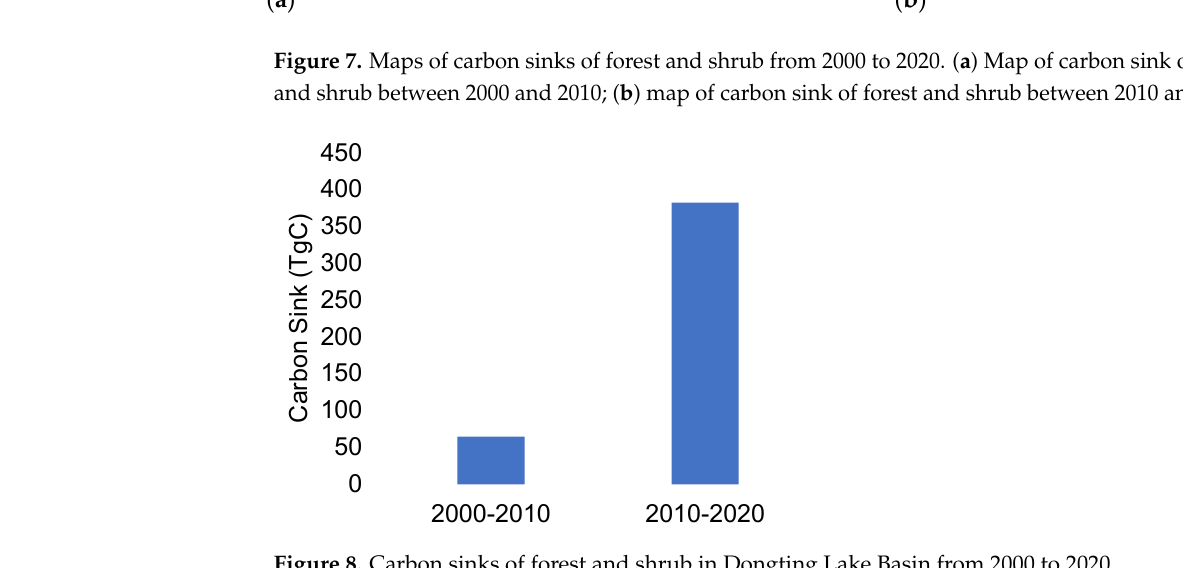
Figure 8. Carbon sinks of forest and shrub in Dongting Lake Basin from 2000 to 2020. Table 4. Carbon sink per unit area from 2000 to 2020 at different carbon density levels. Carbon Density